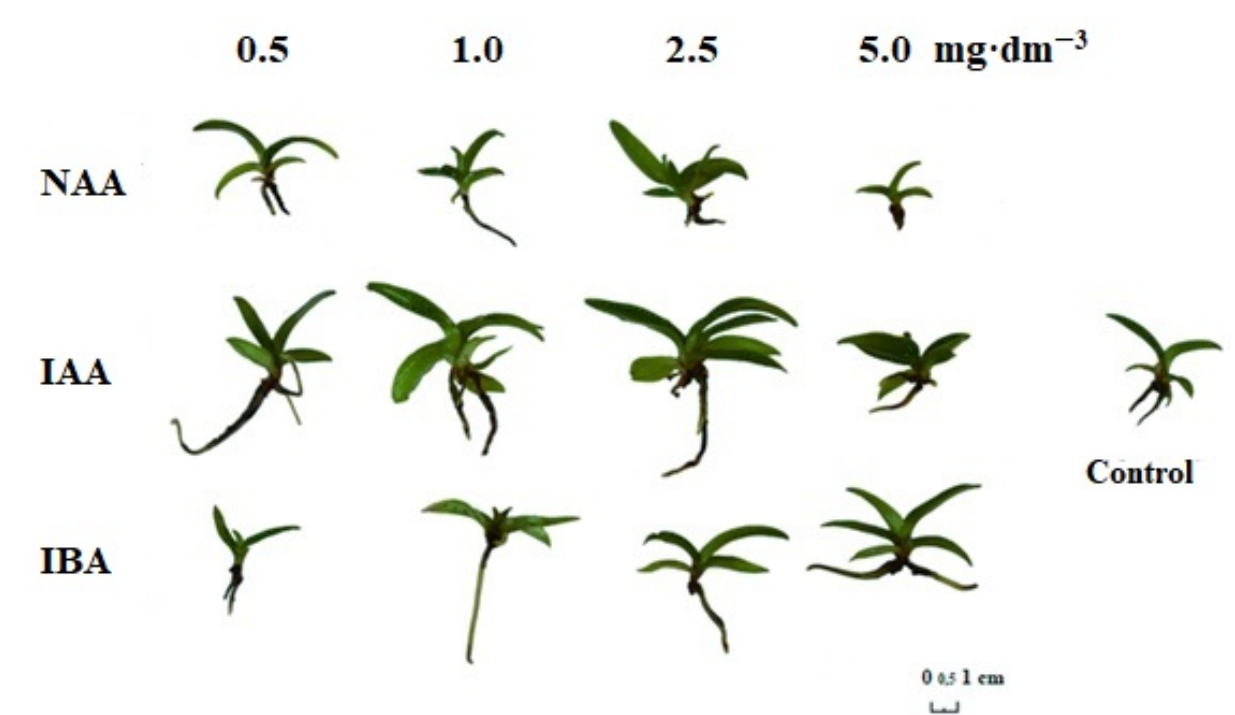
Figure 1. The influence of NAA, IAA and IBA auxins on in vitro rooting and morphological features of Paphiopedilum insigne plantlets.